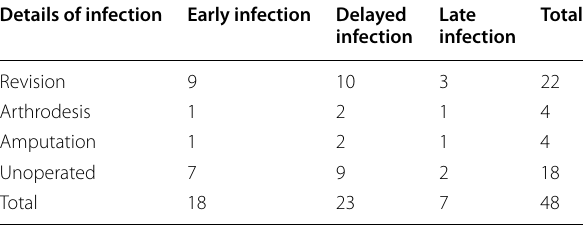
Early infection: Infection was found less than 3 months after operation; Delayed infection: Infection was found from 3 months to 24 months after operation; Late infection: Infection was found more than 24 months after